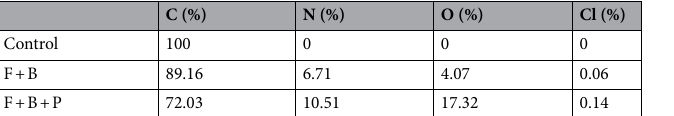
Table 3. Average values of atomic percent of C, O, N and Cl as obtained by EDX technique for Control, F + B and F + B + P PP meshes.